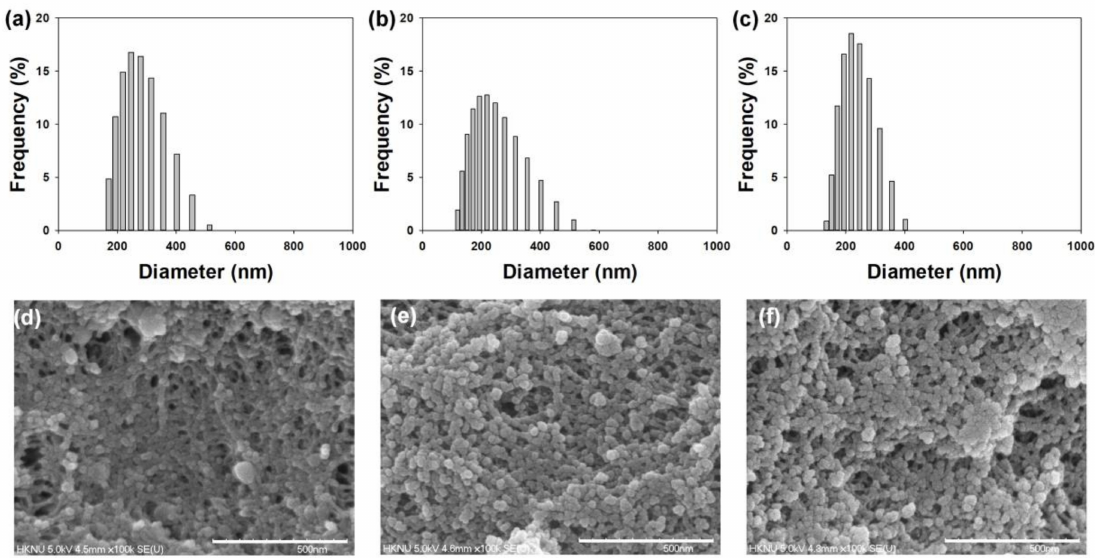
Figure 2. Particle size distributions of ( a ) TA (10 mg) / CaO 2 , ( b ) TA (25 mg) / CaO 2 , and ( c ) TA (50 mg) / CaO 2 . SEM images of ( d ) TA (10 mg) / CaO 2 , ( e ) TA (25 mg) / CaO 2 , and ( f ) TA (50 mg) / CaO 2 . Scale bar: 500